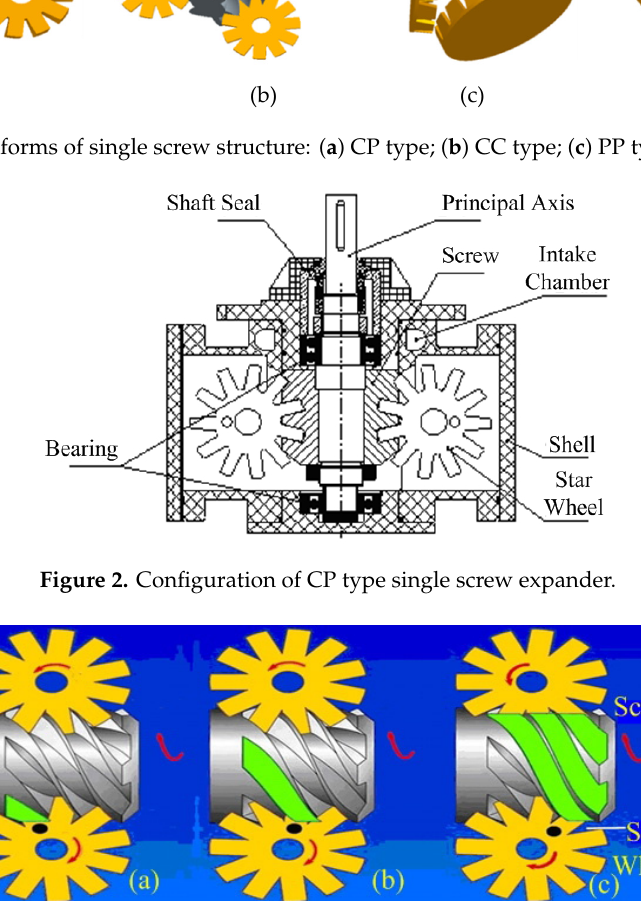
Figure 3. Working processes of CP type single screw expander (a) suction, (b) expansion, and (c) discharge. Table 1. Working condition parameters of the demonstration ORC system Working Condition Parameter.